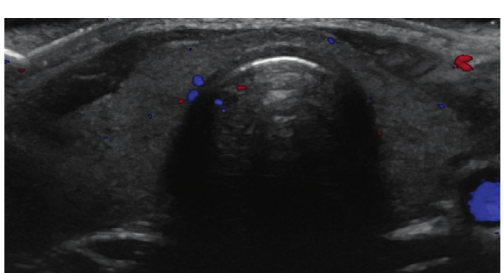
Figure 2: Thyroid ultrasound on post contrast day 7 reveals ho- mogeneous and non enlarged thyroid gland measuring Isthmus: 0.2cm, Right lobe: 2.3 × 4.3 × 0.9 cm Left lobe: 1.3 × 4.3 × 1.1cm. Echogenicity is within normal limits with no increased